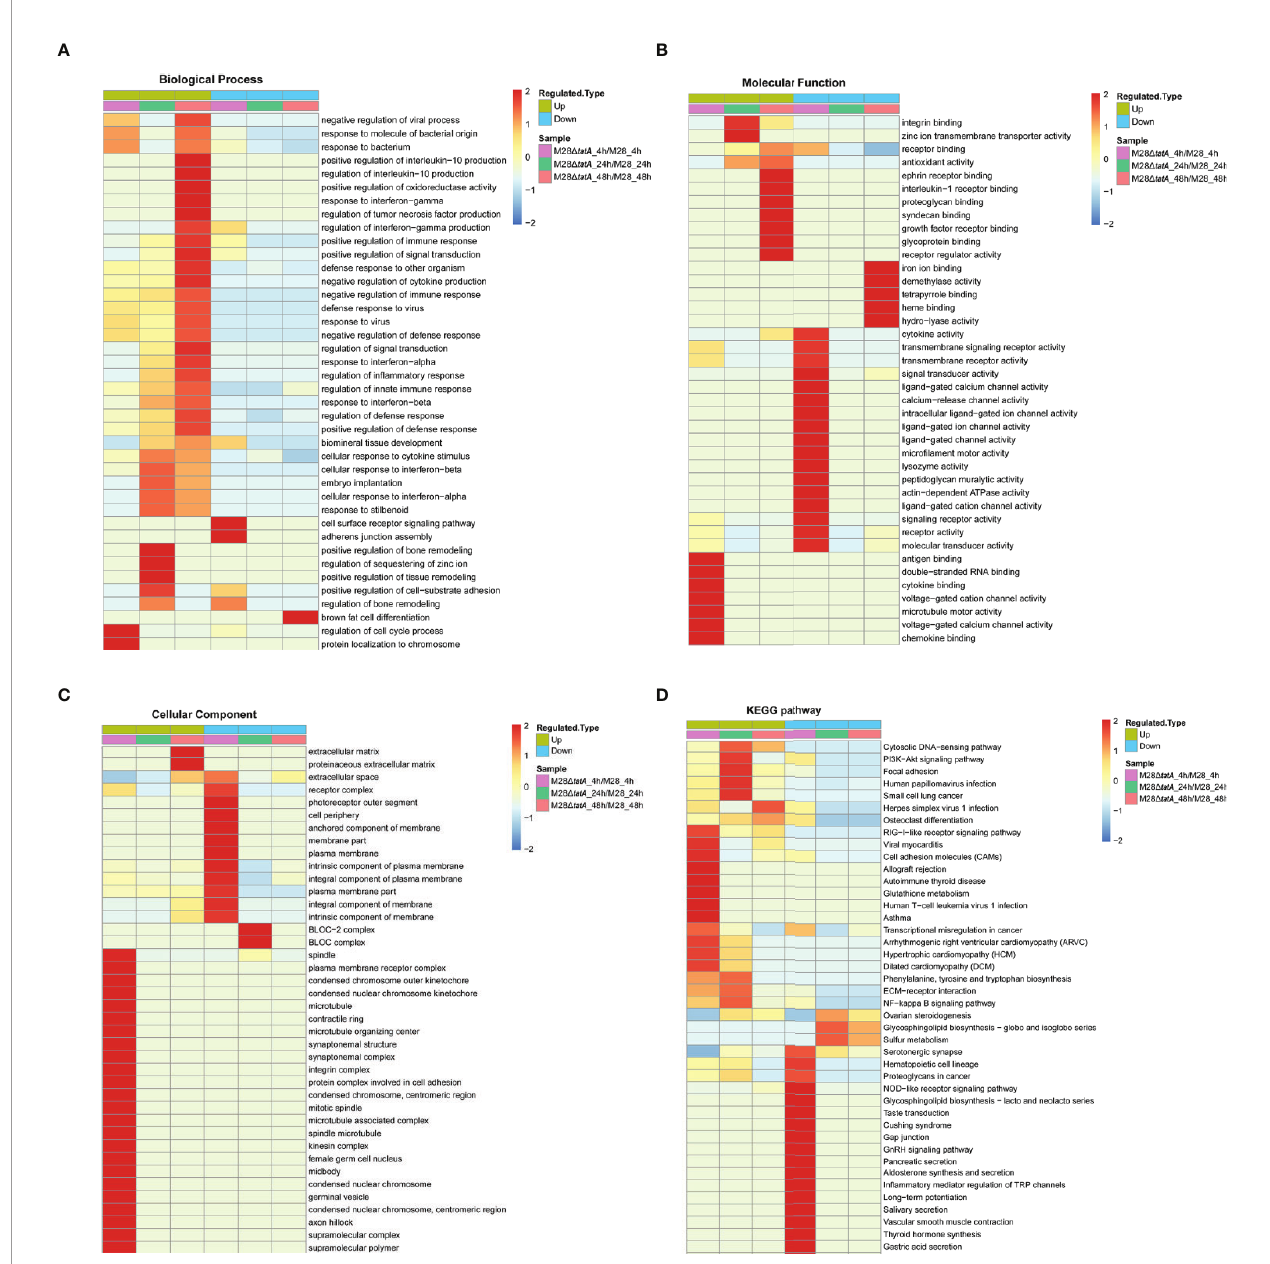
FIGURE 2 | Functional enrichment analysis of DEPs in RAW264.7 cells after infection with M28 and M28 D tatA . (A – C) Cluster analysis heat map based on GO enrichment. (D) Cluster analysis heat map based on KEGG enrichment. The horizontal direction represents the enrichment test results of the different parts, and the vertical direction is the description of the differential expression enrichment-related functions and KEGG pathways. Red indicates a strong degree of enrichment (the darker the red, the stronger the enrichment), and blue indicates a weaker enrichment (the lighter the blue, the weaker the